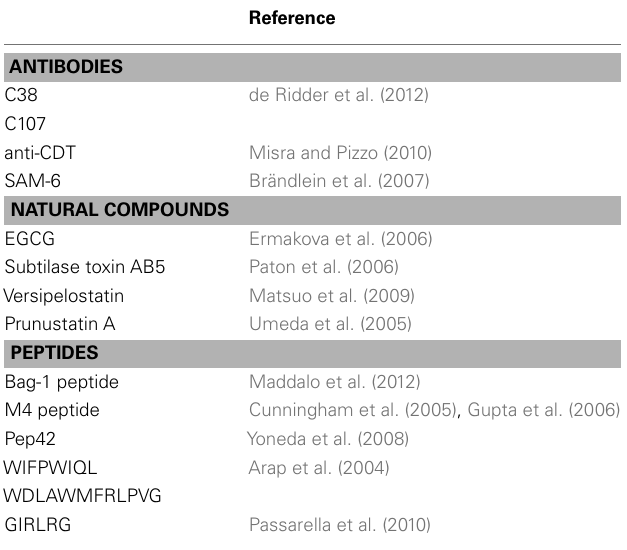
Table 1 | List of GRP78